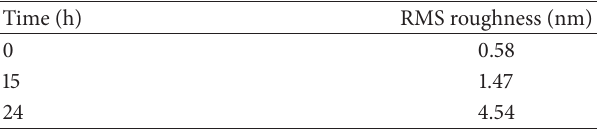
Table 2: Mean diameter, root-mean-square (RMS) roughness for SinA monolayer at different times of UV